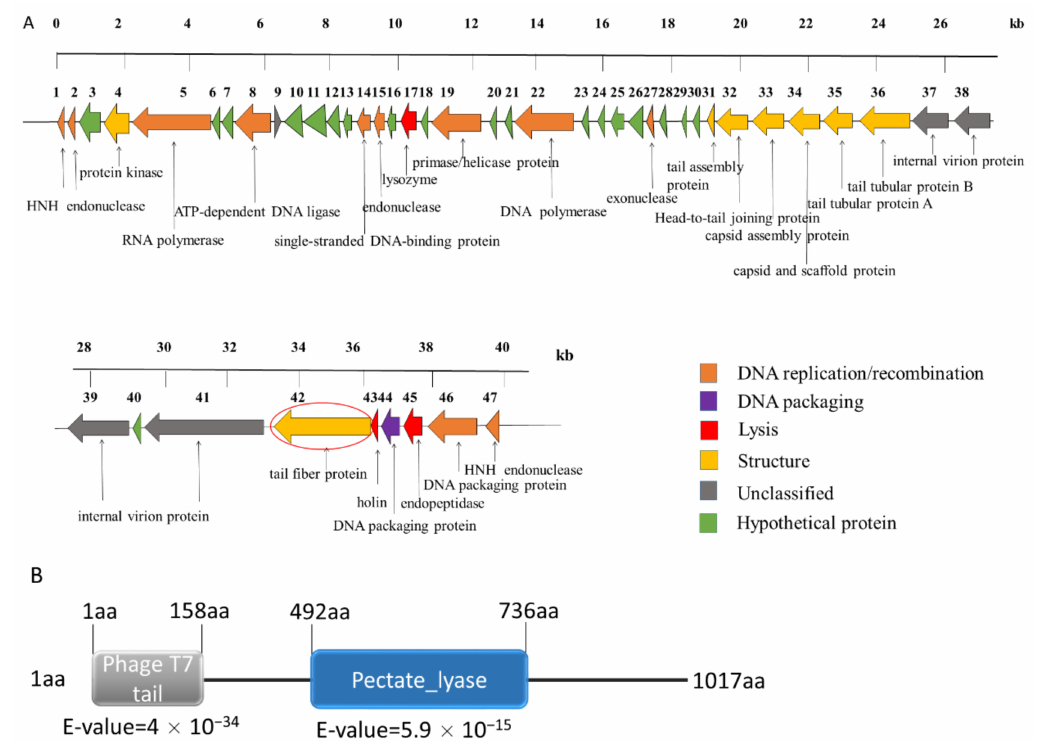
Figure 2. Genomic analysis of the phage SH-KP152410 and in silico analysis of the depolymerase of this phage. ( A ) Linear genome map of the phage SH-KP152410. Different colored arrows represent 47 predicted open reading frames (ORFs) with distinct functions. Orange for phage DNA replication and recombination; purple for DNA packaging; red for host lysis; yellow for structure; gray for unclassified proteins and green for hypothetical proteins. ORF41, the gene encoding the tail fiber protein was predicted to be a putative polysaccharide depolymerase and circled in red. ( B ) Bioinformatic analysis of the putative polysaccharide depolymerase of the phage SH-KP152410. Using BLASTp and HHpred, the result characterizes a 1017aa protein with two conserved domains: phage T7 tail fiber (residue 1–158) and pectate lyase domain (residue